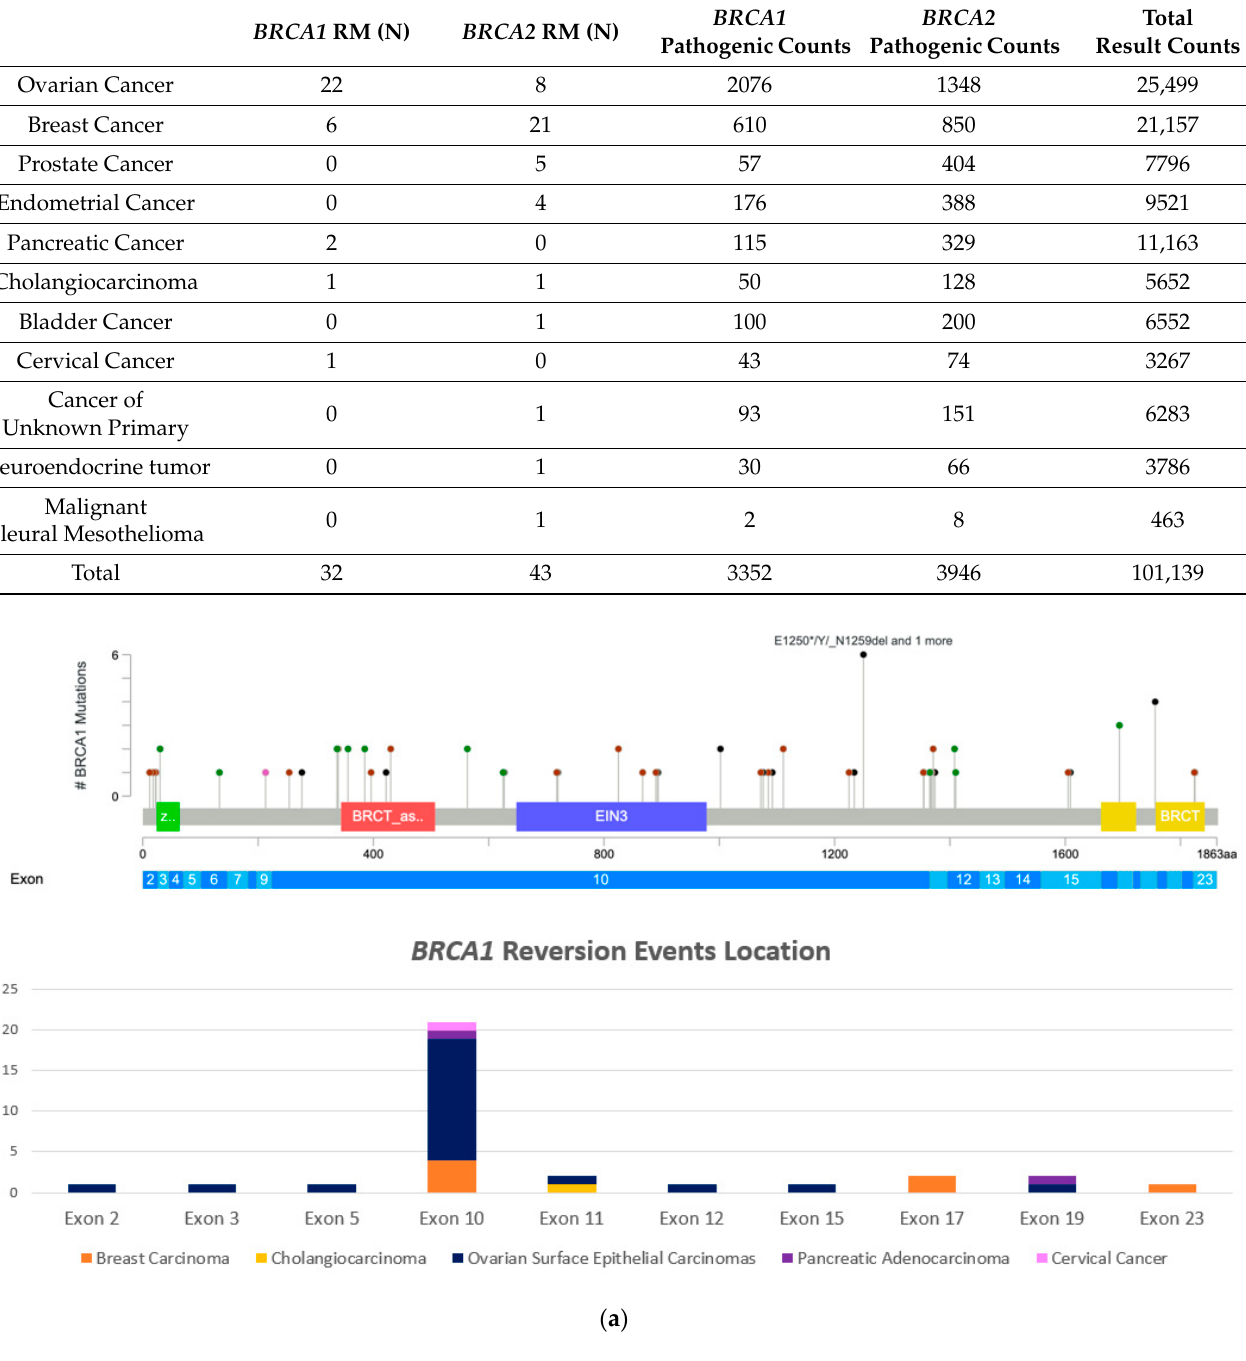
Table 1. The number of detected BRCA1/2 mutations and total of reversion mutations (RM) in different cancer types in our cohort of 247,926tumor samples.